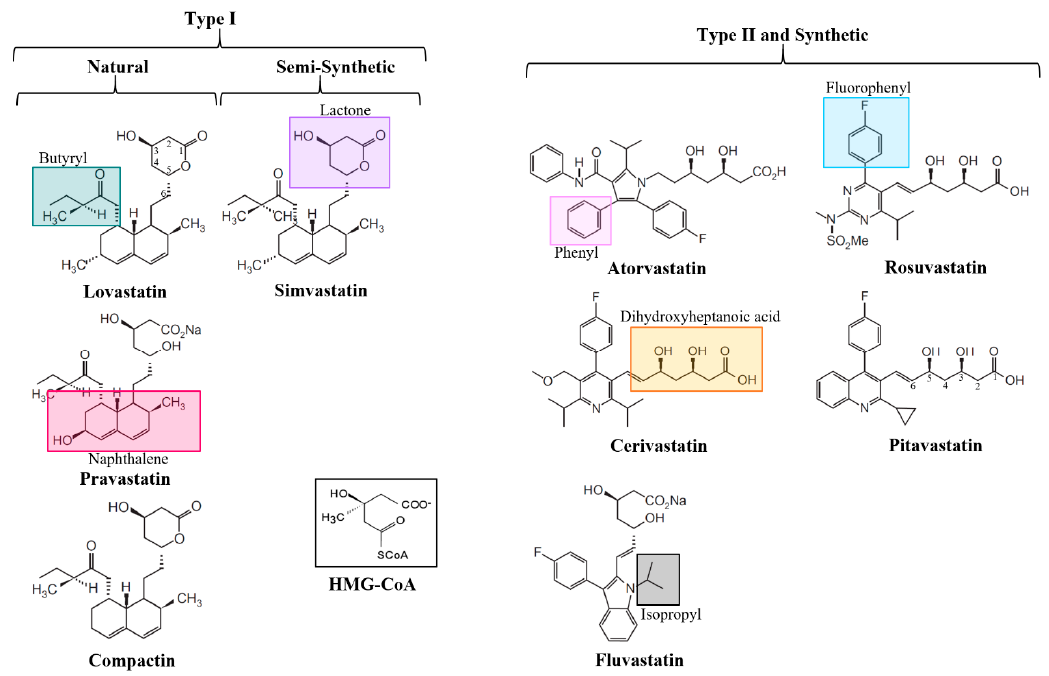
Figure 3. Classification of statin drugs. Statins are classified based on their chemical structure (Type I and II), or synthesis (Natural, Semi-Synthetic, and Synthetic). HMG-CoA, the natural substrate of HMGR, does not fall into any category. The HMG-CoA-like pharmacophore lactone is isolated in purple. The butyryl group of Type I statins is isolated in green. The naphthalene ring of Type I statins is isolated in magenta. The phenyl group of Type II statins is isolated in pink. The fluorophenyl group of Type II statins is isolated in blue. The dihydroxyheptanoic acid pharmacophore of Type II statins is isolated in orange. The isopropyl group of Type II statins is isolated in grey.